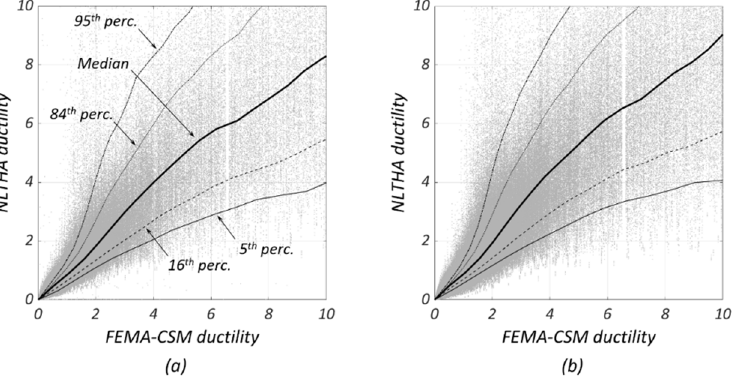
Figure 5. Comparison between ductility demands from the CSM by FEMA 440 and from NLTHA: ( a ) Suite 1-A, and ( b ) Suite 1-B.